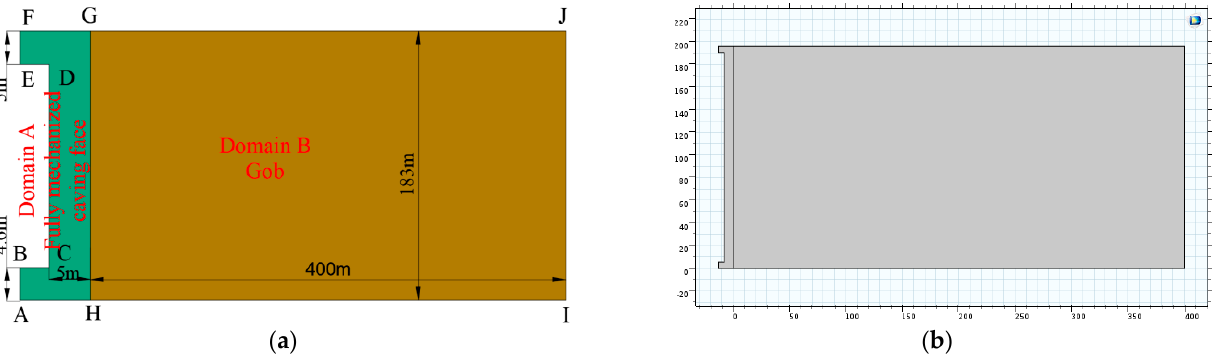
Figure 1. Calculation model. ( a ) Geometric model, ( b ) Simulation model.